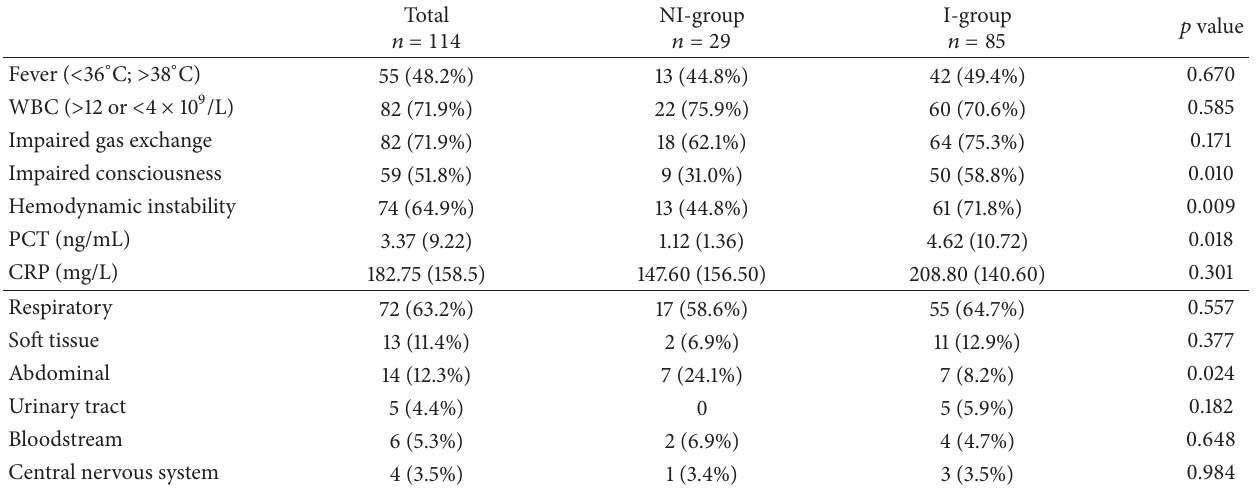
Table 2: Clinical signs and suspected source of infection at enrollment ( 𝑡 0 ).